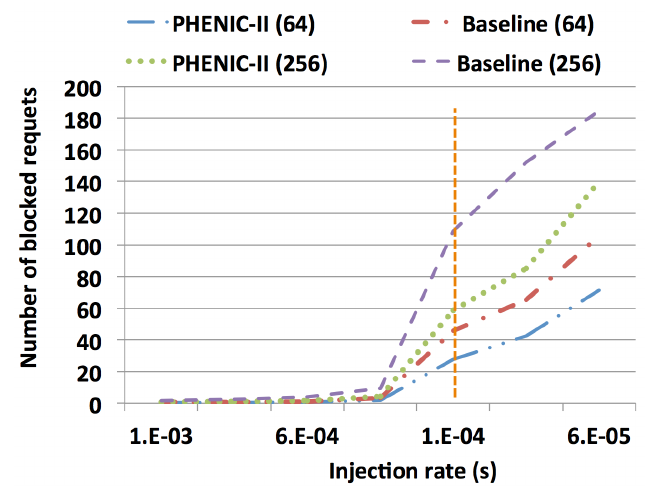
Figure 12. Comparison under random uniform traffic of the number of blocked requests having reaching more than half of the network diameter. The vertical dashed line represent the near-saturation